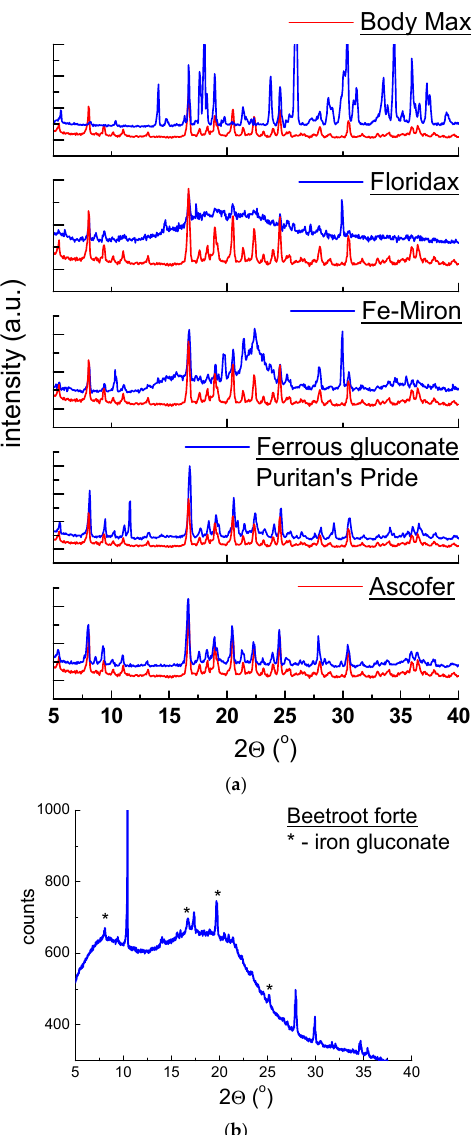
Figure 3. Diffraction patterns for dietary supplements: ( a ) Ascofer , Ferrous gluconate Puritan’s Pride , Fe-Miron , Floridax , Body Max and ( b ) Beetroot forte . Position of diffraction lines ( 2 θ angles) and the calculated values of interplanar dis- tances d hkl have values close to data obtained for pure iron (II) gluconate (Table 2). | ∆ 2 θ |